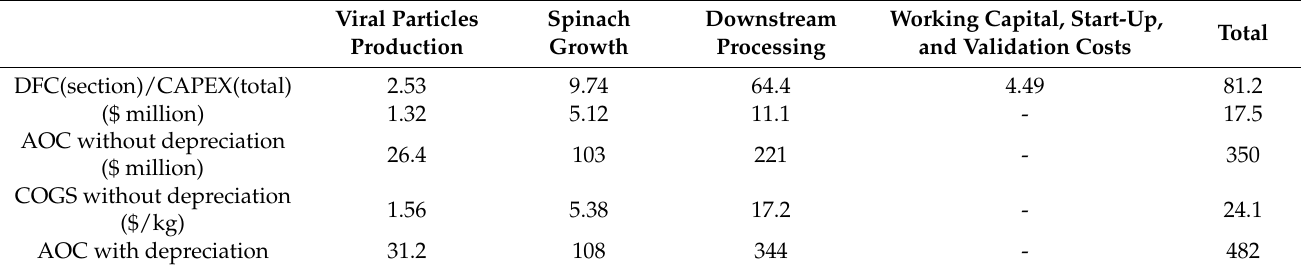
Table 2. Direct fixed capital (DFC), capital expenditures (CAPEX), annual operating cost (AOC), and cost of goods sold (COGS) for spinach transient thaumatin production facility. Depreciation is based on the 10-year straight line method.